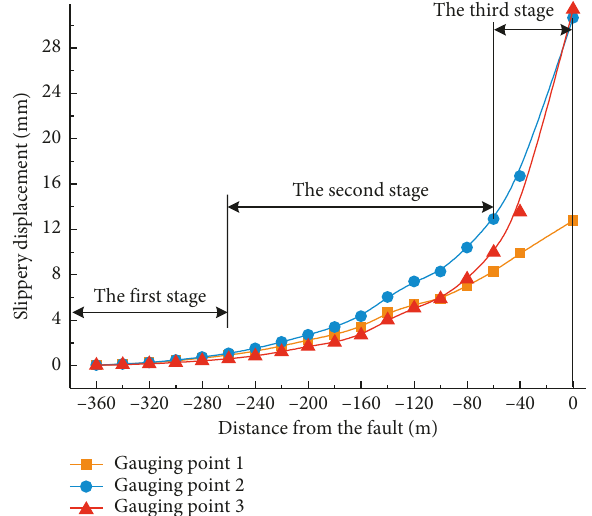
Figure 11: Fault slippery displacement with advance of the working